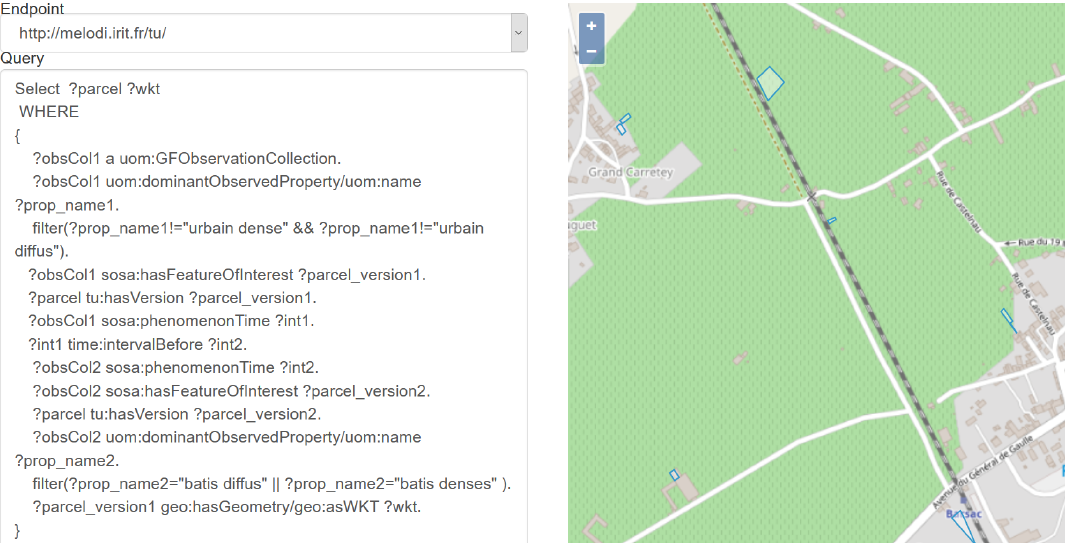
Figure 7. Location of vineyard parcels (surrounded areas) of the Barsac village in 2017.